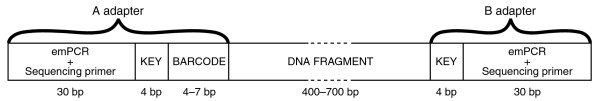
Barcode adapter design. Validated barcode sequences are added to the end of the 454 A adapter via DNA synthesis (Integrated DNA Technology). The lengths of each portion of the adapter and the approximate length of the insert are indicated. Validated barcodes are exactly 11 flows in length and range from 5 to 8 bases. emPCR, emulsion PCR.